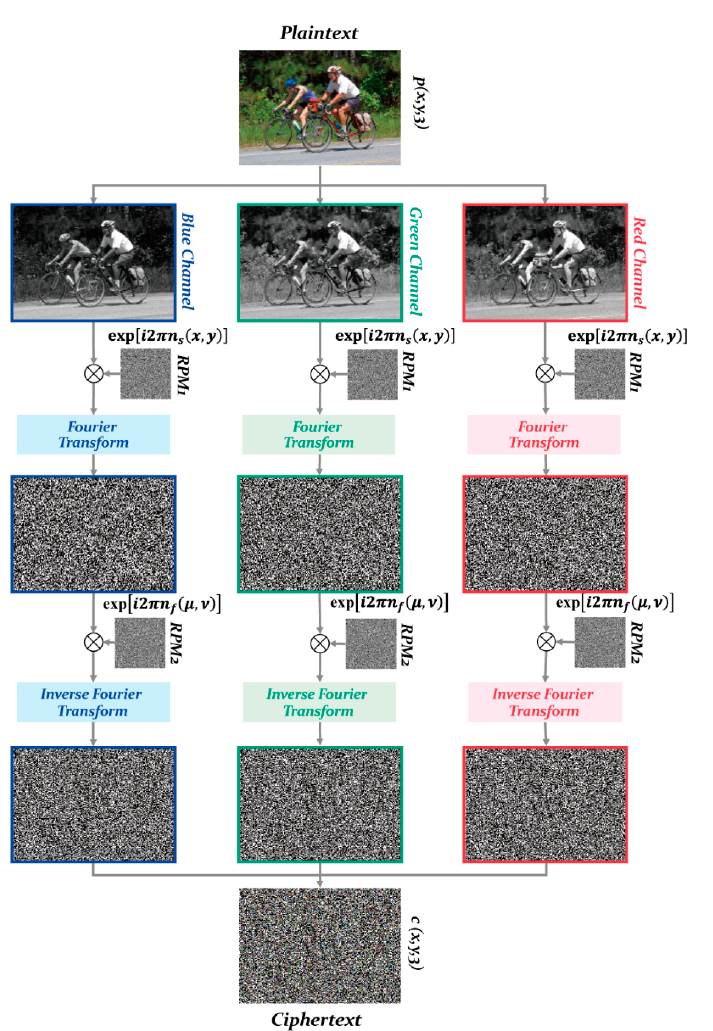
Figure 2. Encryption process of DRPE for color images. The image used is from the Flickr8k dataset. For visualization, only the phase images are used in the diagram.